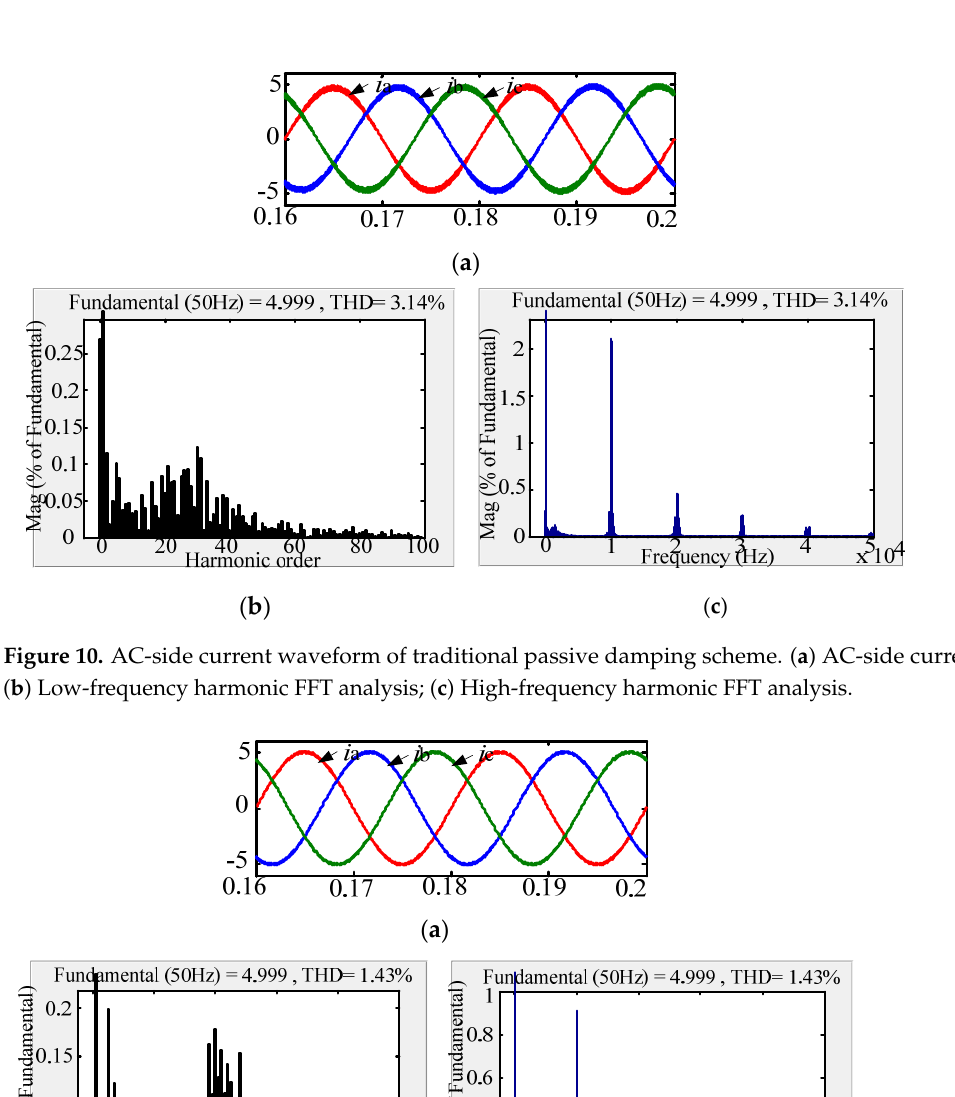
( c ) Figure 12. AC-side current waveform of split inductor damping solution 2. ( a ) AC-side current; ( b ) Low-frequency harmonic FFT analysis; ( c ) High-frequency harmonic FFT analysis. Comparing the AC-side current low-frequency harmonic FFT analysis of the three schemes, it can be concluded that the low-order harmonic content of the three schemes meets the current harmonic content of the international grid. In addition, the three damp- ing schemes have almost the same system gain at low-order frequencies and resonant fre- quencies, which is consistent with theoretical analysis. Comparing the AC-side current harmonic content of the two new damping schemes at the low-order frequency, the AC- side current quality of the split-inductive damping solution 2 is better. Comparing the AC-side current high frequency harmonic FFT analysis of the three damping schemes, at the switching frequency and the integer multiple frequency, the har- monic content of the proposed scheme is more than double that of the conventional solu- tion. Moreover, it is equal to the gain of the high-order frequency of the undamped sys- tem, which is consistent with the theoretical analysis. Comparing the two-side damping